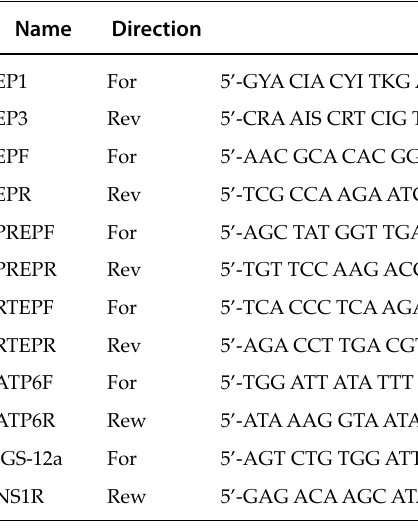
Table 2. PCR primers used in this